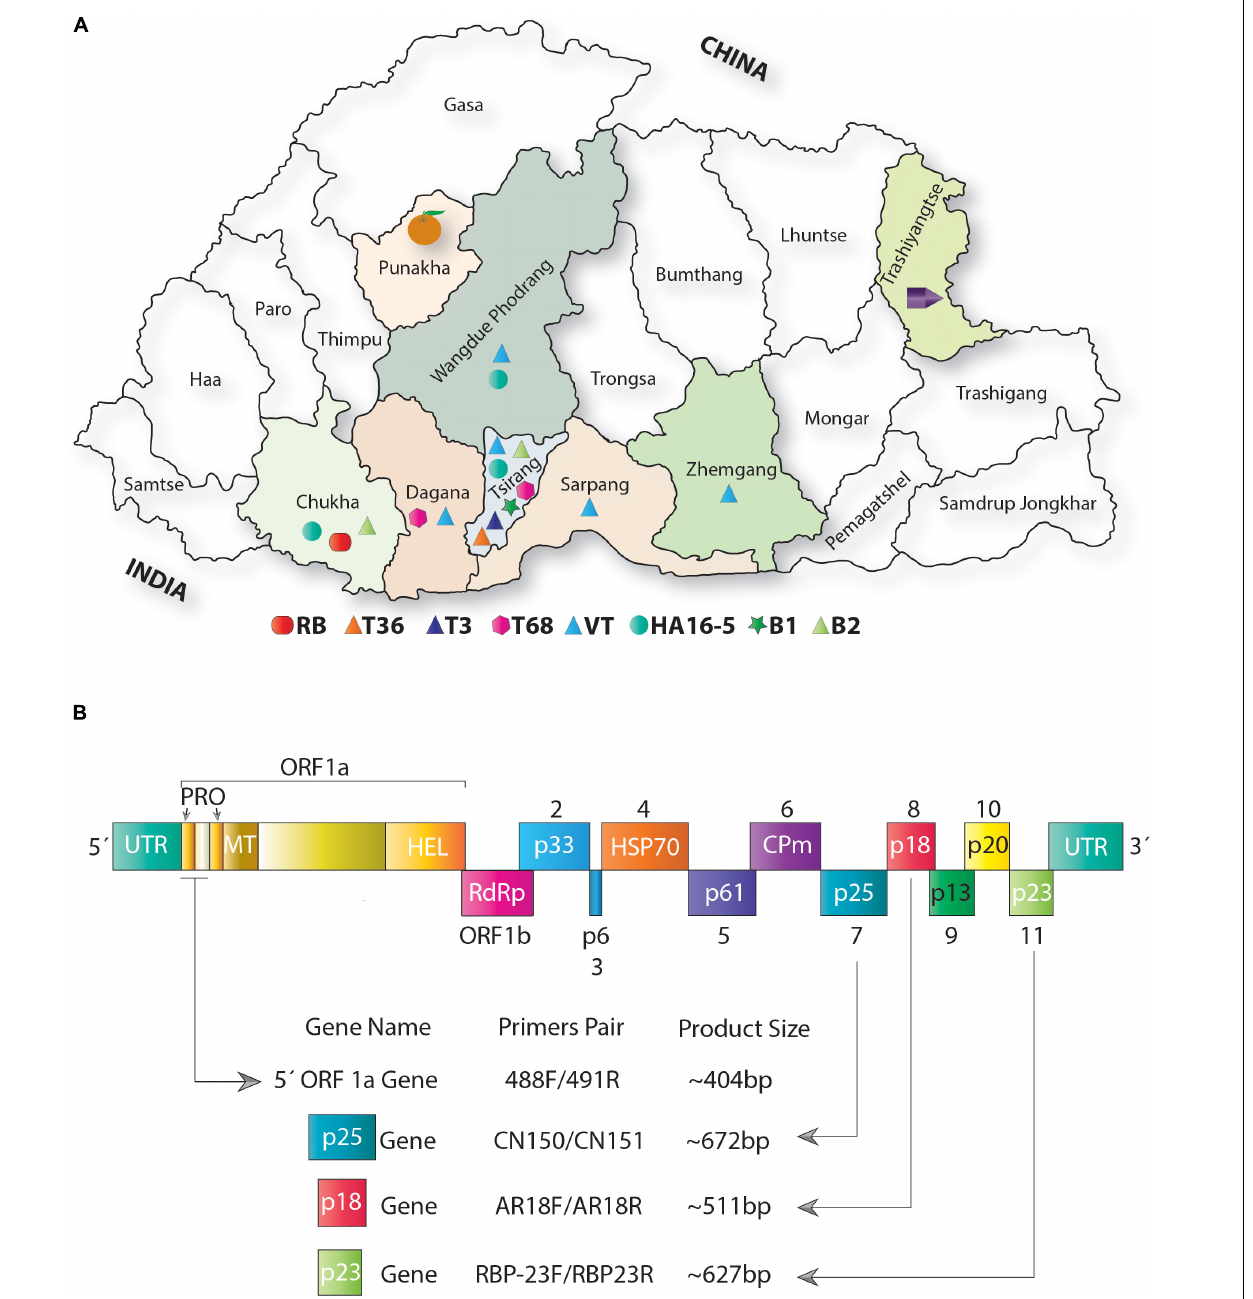
FIGURE 2 | Distribution of citrus tristeza virus (CTV) variants across major citrus growing regions of Bhutan. (A) Map showing the geographic locations of Bhutan. Districts filled with color from where the samples were collected. Phylogenetically distinct variants identified among Bhutanese CTV isolates are shown with different colored shapes and placed at the bottom of the map (please refer to Figures 4 , 5 for detailed phylogenetic classification of CTV variants). The district “Tsirang” was identified as the hotspot of the CTV variants showing the presence of seven major CTV variants out of nine variants identified in this analysis. The district “Chukha” shows the unique presence of a novel variant RB found absent in other districts of Bhutan. Most districts where samples were collected show a high incidence of CTV. The district where CTV was detected with unknown variants is shown with a purple pentagon cartoon. Districts where no CTV and its variants were detected are indicated by an orange cartoon. (B) Schematic representation of the genome organization of CTV: colored boxes depict the complete open reading frame (ORF) of the protein-coding and the untranslated region (UTR). Protein coding genes are labeled from 1 to 11. Four CTV genomic locations were targeted for PCR amplification shown with the help of arrows. Primers pair was used to PCR amplify these four genomic locations, and the size of the PCR-amplified product obtained is indicated at the bottom of the image. PRO, papain-like protease domain; MT, methyltransferase domain; HEL, helicase domain; RdRp, RNA-dependent RNA polymerase protein; HSP, heat shock protein; and CPm, minor capsid